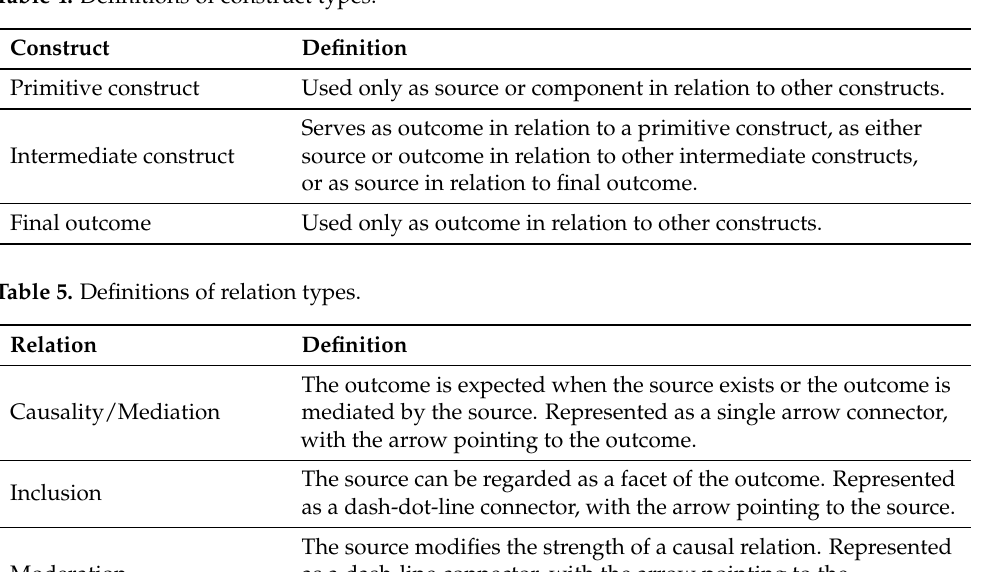
Table 4. Definitions of construct types.